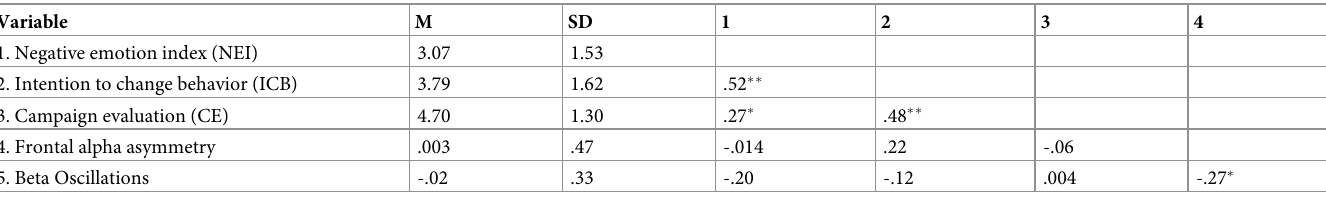
Table 1. Means, standard deviations, and correlations between dependent variables.